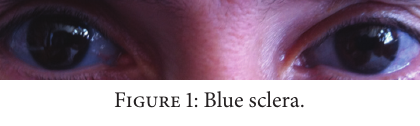
Figure 1: Blue sclera.